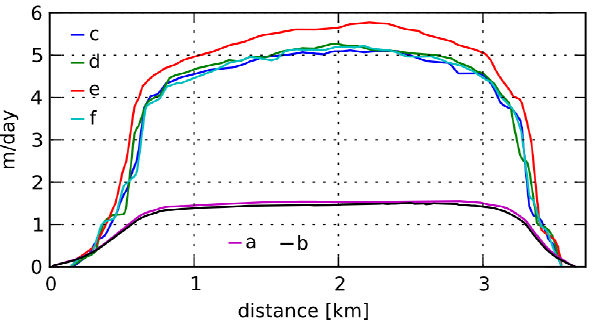
Figure 5. Surface velocity on Crane Glacier at profile C1, derived from ERS InSAR of Dec. 1995 (a), Dec. 1999 (b); from TerraSAR-X of Oct. 2008 (c), Nov. 2008 (d), April 2009 (e), Nov. 2009 (f).